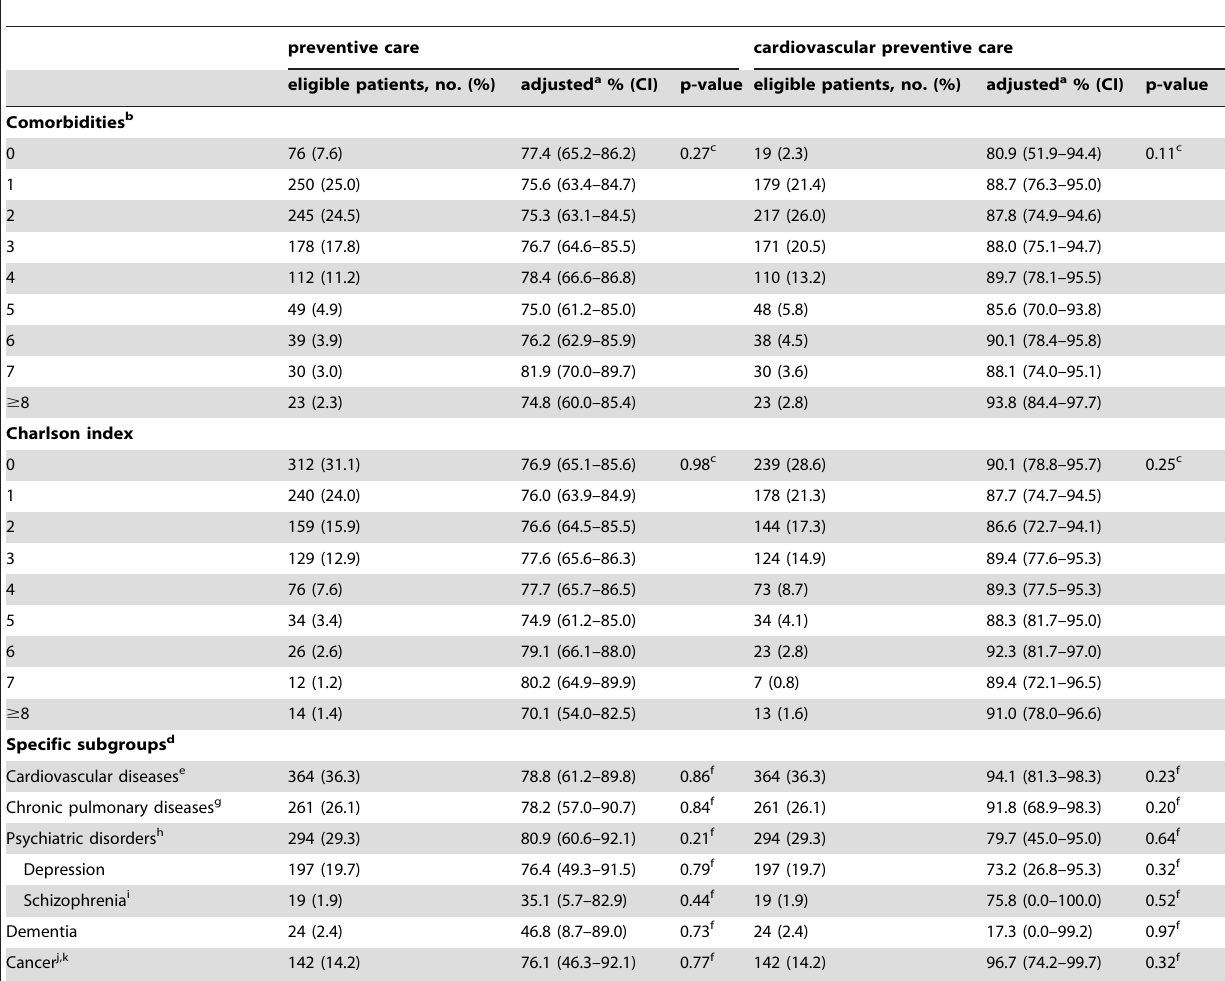
Table 2. Number of comorbidities, Charlson index and quality of preventive care and cardiovascular preventive care, analyzed also for specific